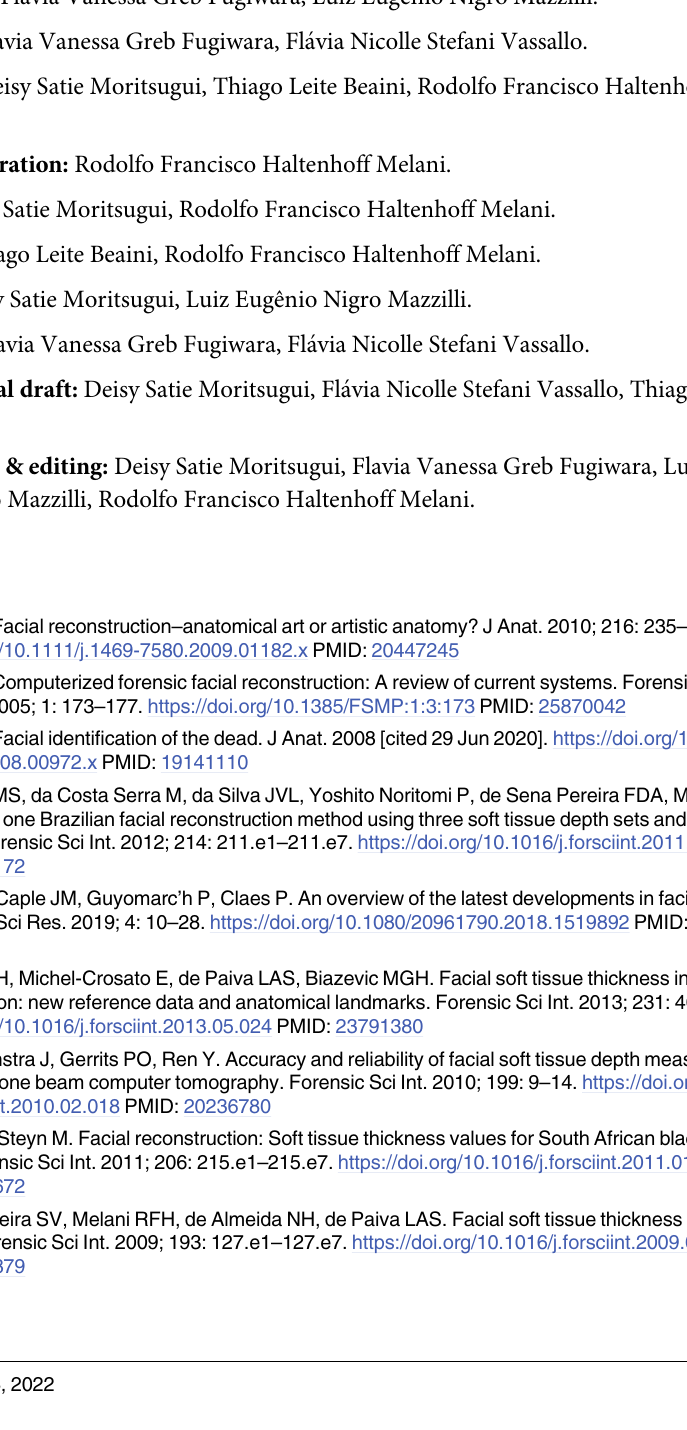
S2 Table. FSTT means in age groups in both